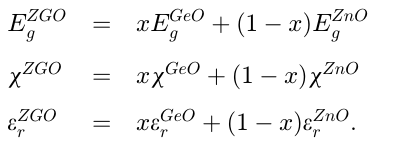
Table 1. Parameters of the AZO/ZnGeO/Cu